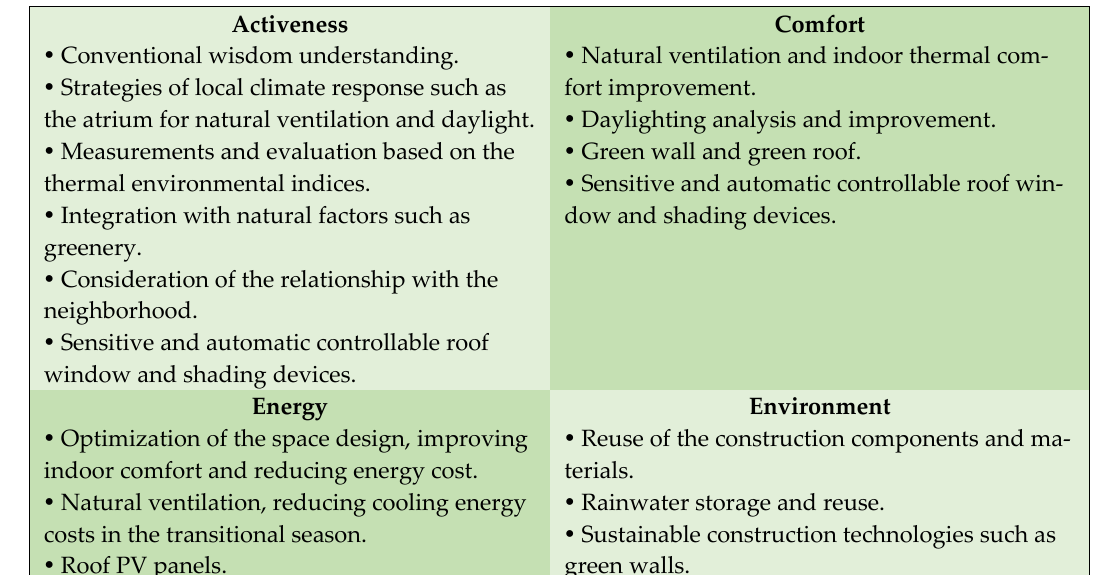
Figure 23. Strategies based on the ASAH guidelines and field survey.